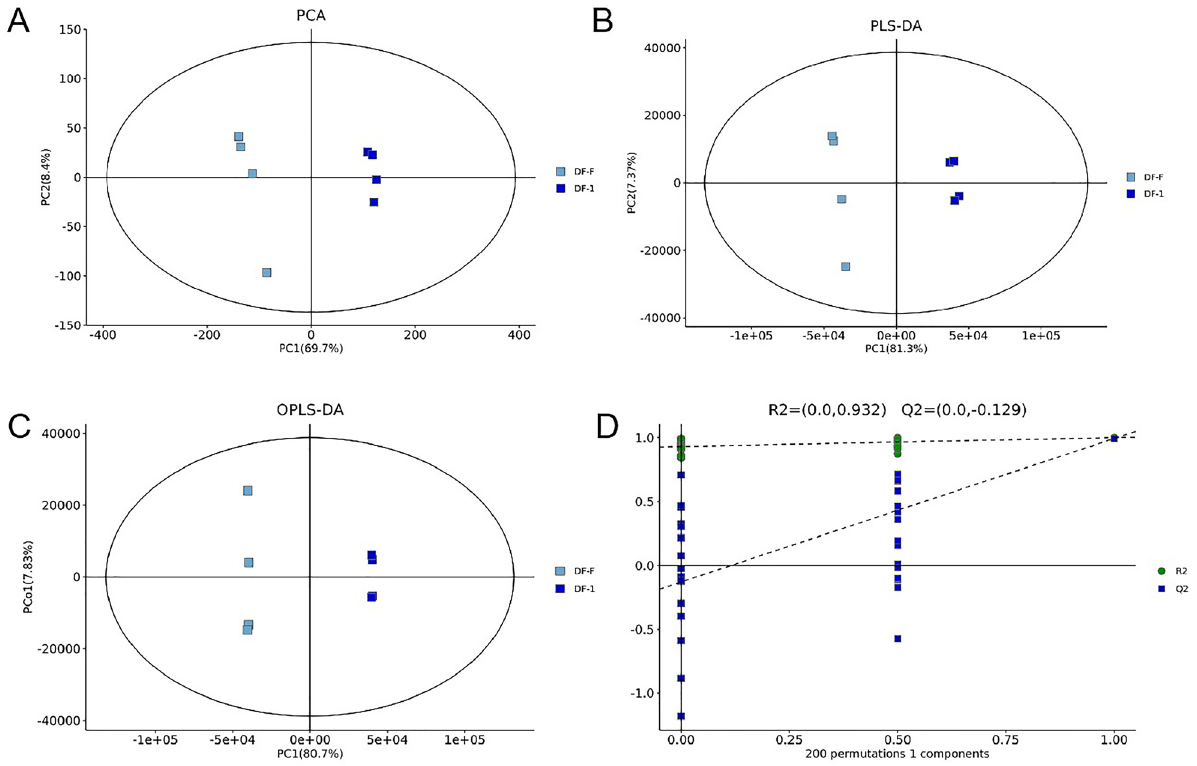
Figure 2. Model of the multivariate analysis and its cross-validation. ( A ): PCA for TPFD samples versus FSD samples. ( B ): PLS-DA for TPFD samples versus FSD samples. ( C ): OPLS-DA for TPFD samples versus FSD samples. ( D ): Response permutation testing of the model predicted by OPLS-DA.